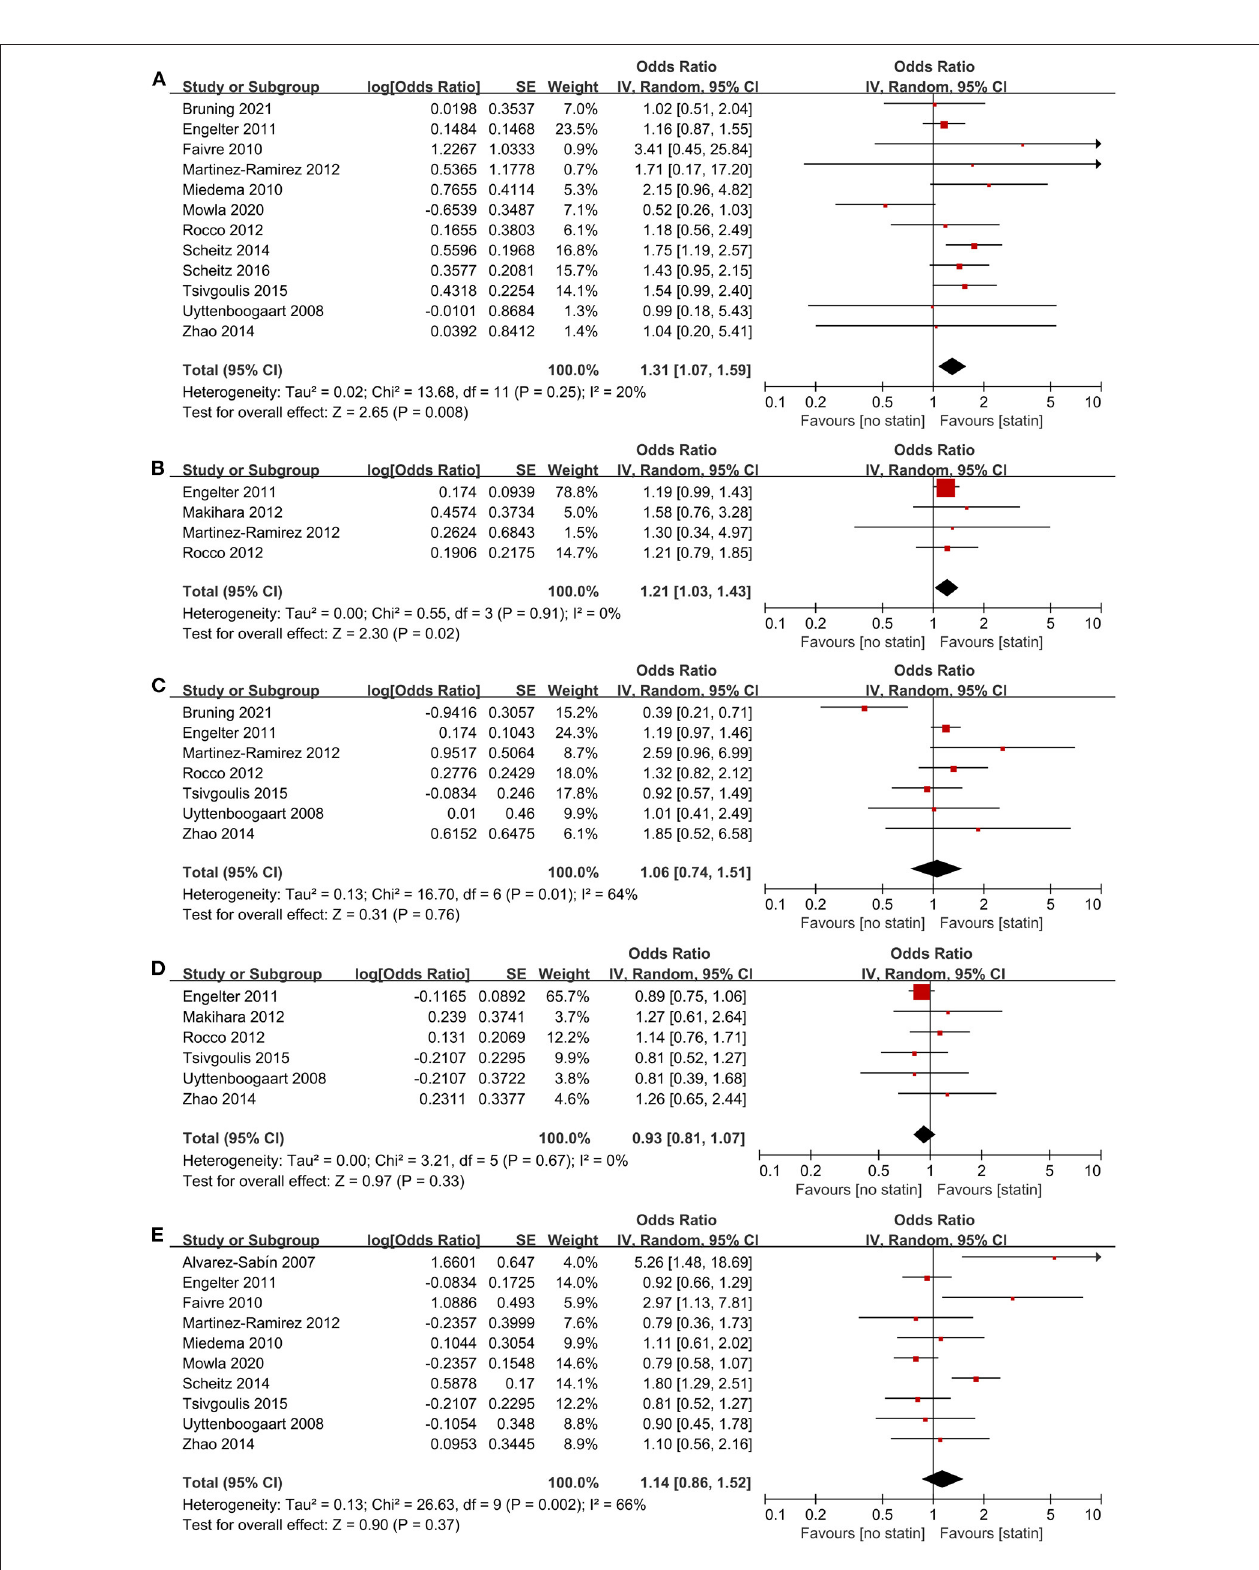
FIGURE 2 | Association of pre-stroke statin use with (A) symptomatic intracranial hemorrhage, (B) any intracranial hemorrhage, (C) 3-month mortality, (D) 3-month favorable functional outcome, and (E) 3-month functional independence.